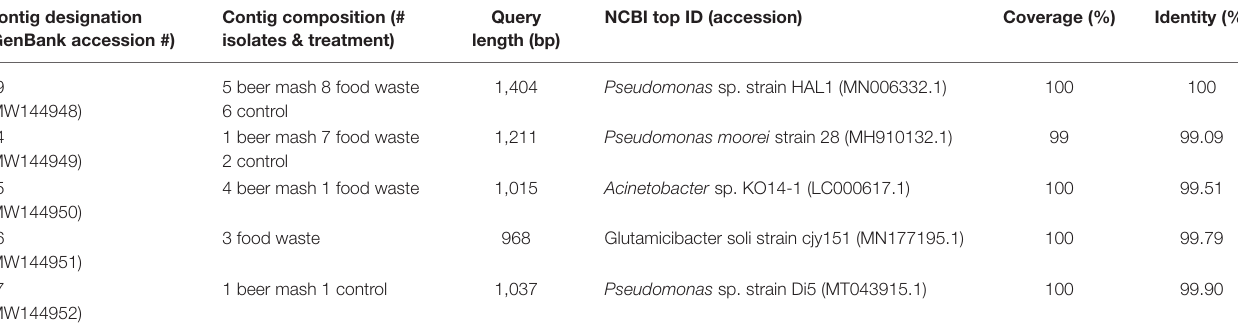
TABLE 2 | Bacterial species identified by 16S rRNA gene Sanger sequencing and culturing approach. Contig designation Contig composition (# (GenBank accession #) isolates &